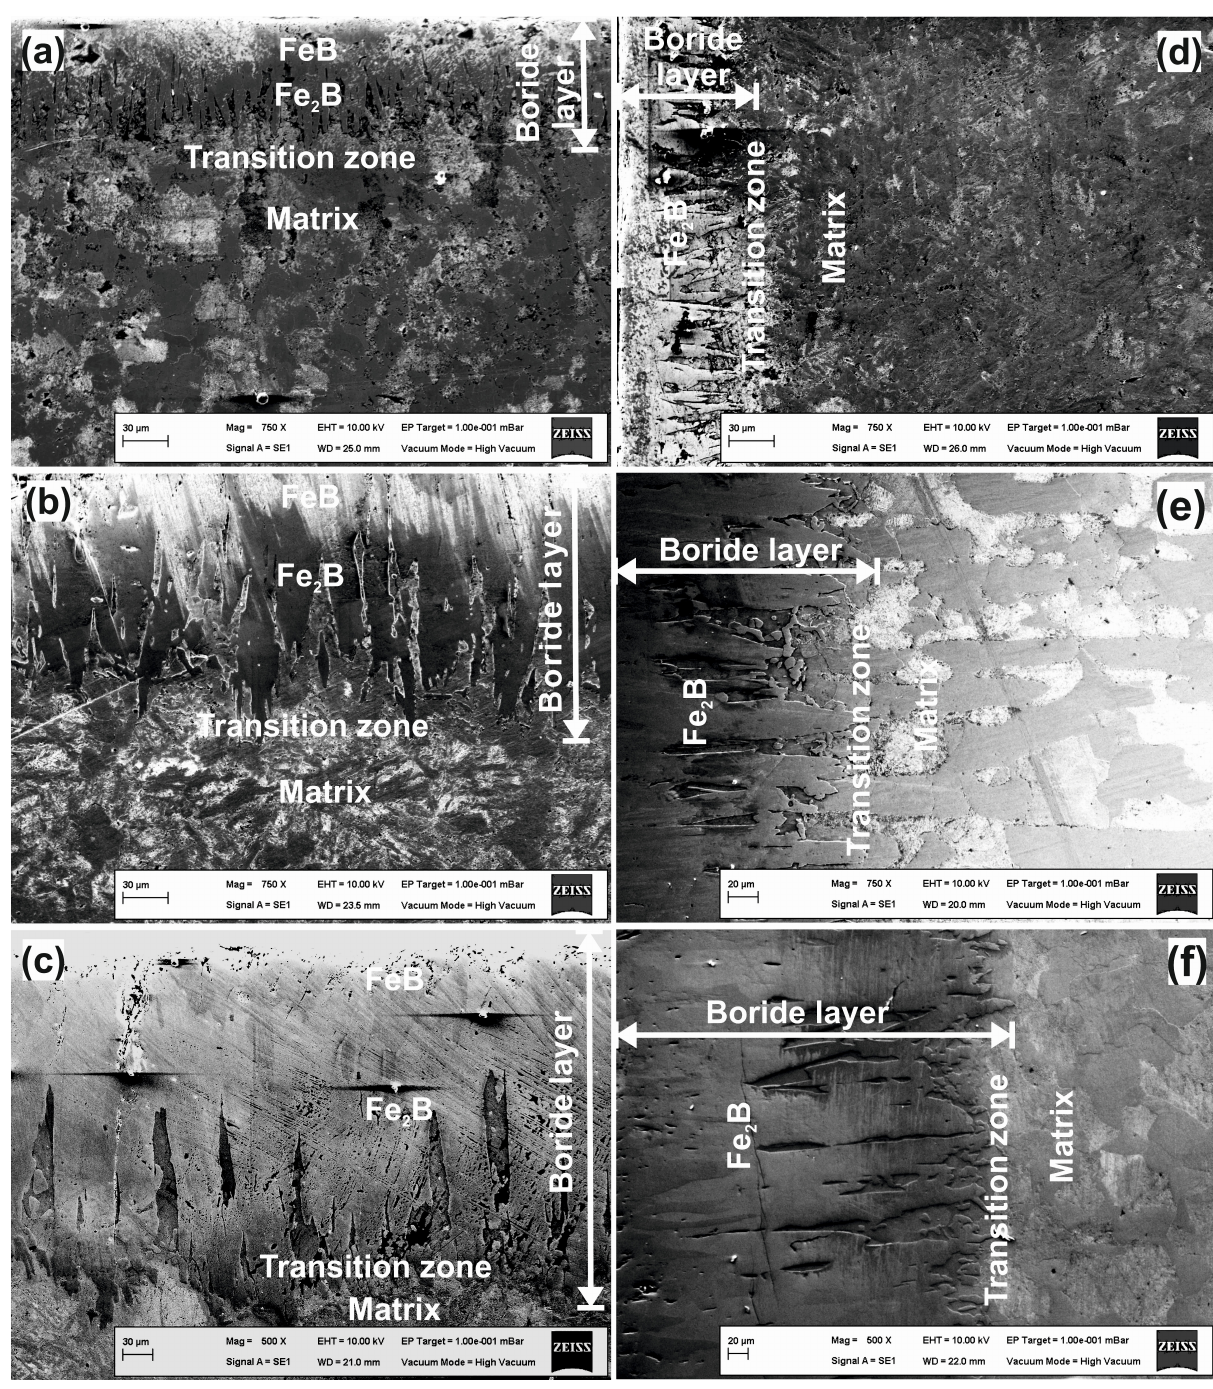
Figure 4: SEM microstructures of borided samples; (a) Hardox 450-800 ∘ C, (b) Hardox 450-900 ∘ C, (c) Hardox 450-1000 ∘ C, (d) HiTuf-800 ∘ C, € HiTuf-900 ∘ C, and (f) HiTuf-1000 ∘ C.